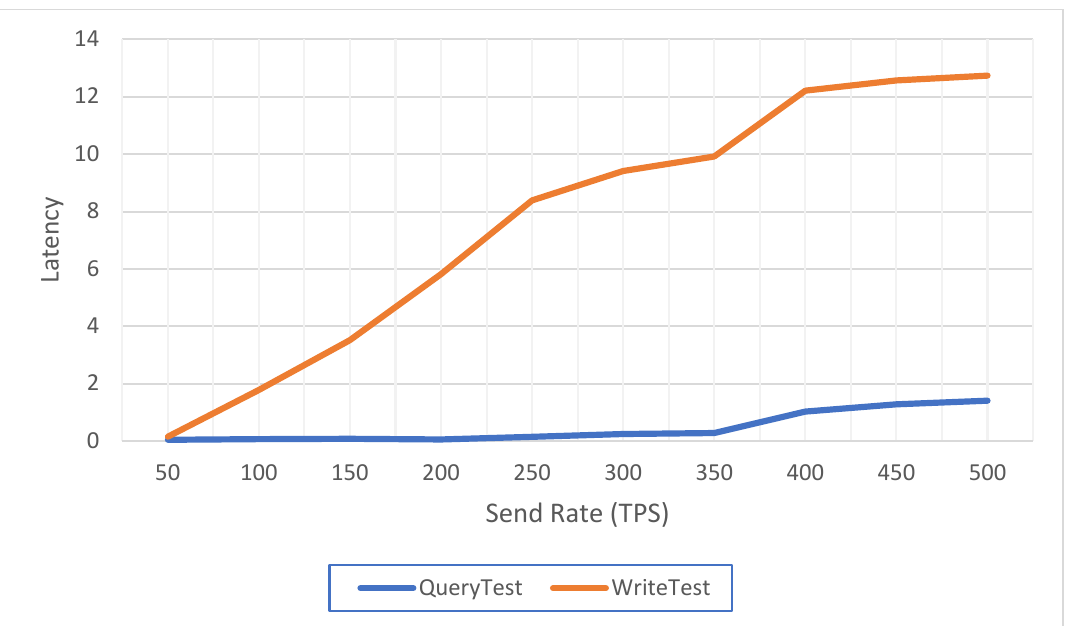
Figure 12. Latency of the system at various send rates.